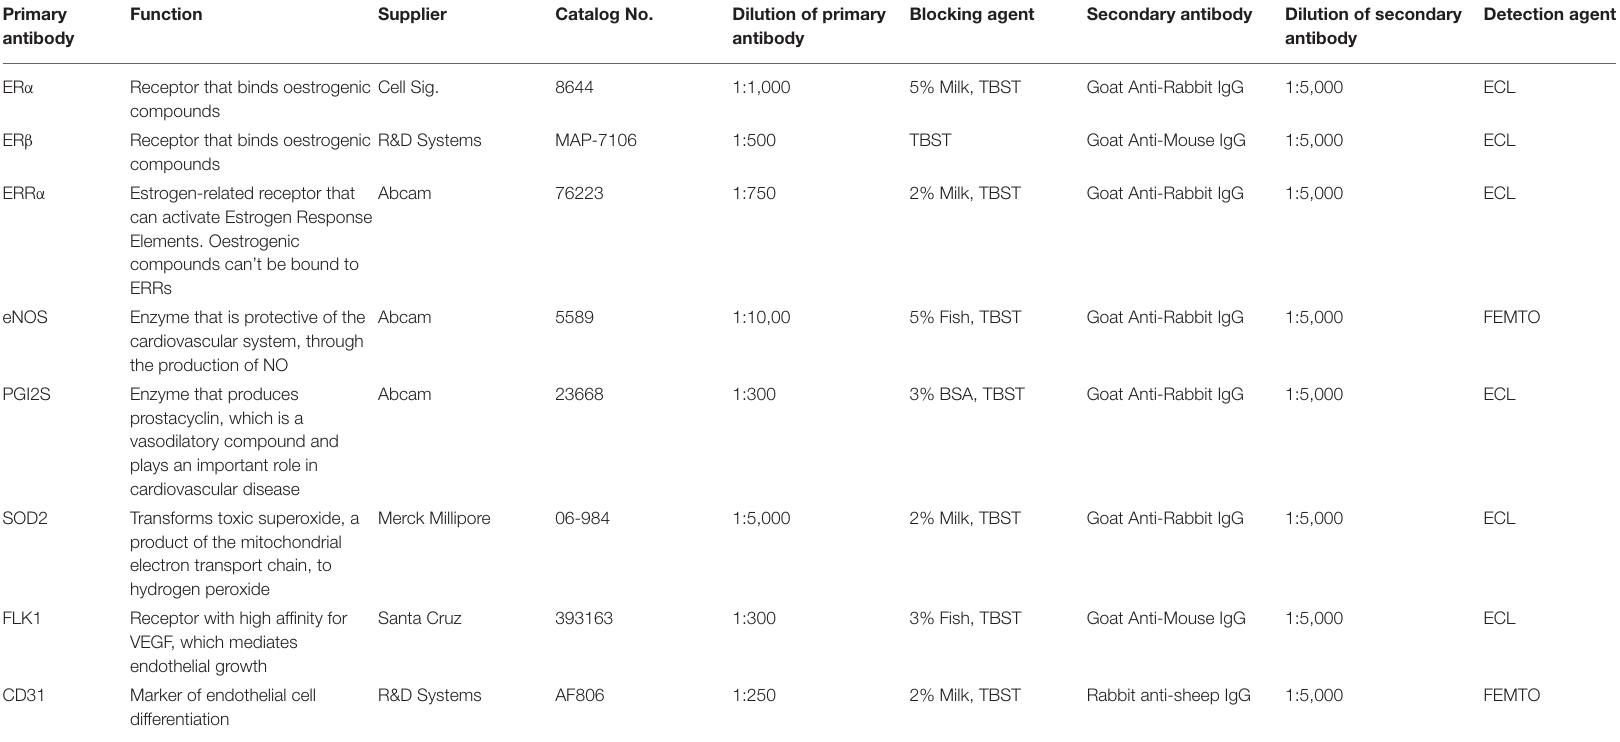
TABLE 1 | Overview of antibodies used for western blotting. Primary Function Supplier Catalog No. Dilution of primary antibody